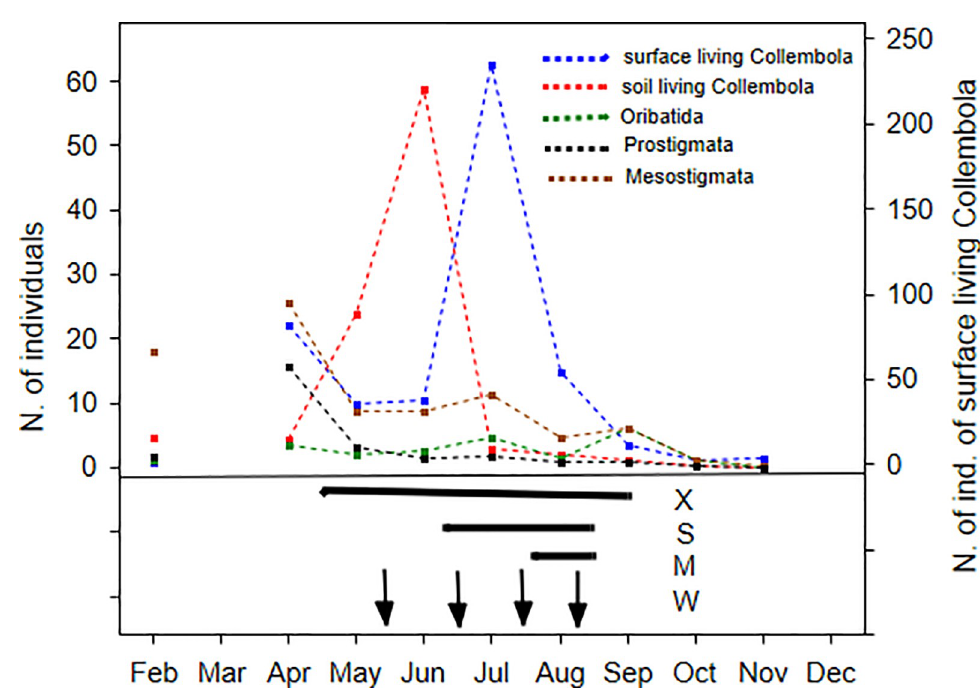
Fig 2. Dynamics of soil mesofauna. Monthly dynamics of the total activity density of different microarthropod groups in the control plots in 2015. Under the figure of these dynamics the timing and duration of the treatments are shown, to see parallel where the treatments possibly affect these natural dynamics. Note: epedaphic Collembola: blue, euedaphic Collembola: red, Oribatida: green, Prostigmata: black and Mesostigmata: brown dotted line. Horizontal bars denote the time periods of the different drought treatments: for treatment 1: X: extreme drought in 2014; for treatment 2: S: severe drought, M: moderate drought in 2015, vertical arrows show water addition events. X axis: time (month) and y axis: number of individuals caught (epedaphic Collembola are on the left y